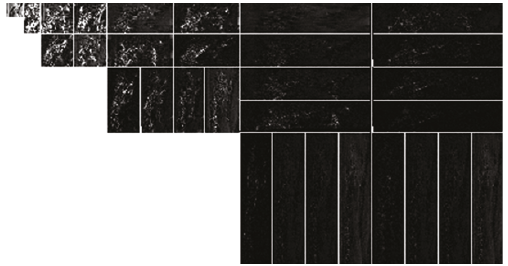
Figure 4: Contourlet decomposition of Lena.